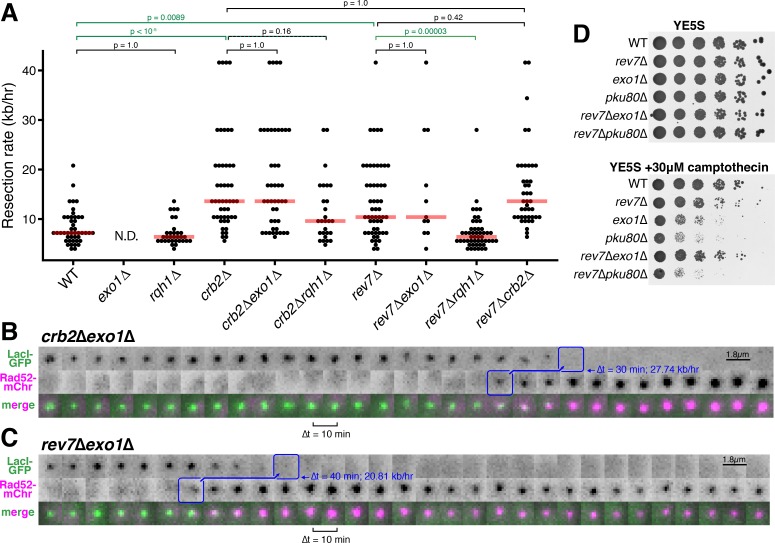
Rev7 and Crb2 act through the RecQ helicase, Rqh1, and not Exo1, to inhibit long-range resection.(A) Epistasis analyses of long-range resection rates from single-cell measurements. exo1∆ rates cannot be determined (N.D.) because resection through the LacO array does not complete within 5 hr of data acquisition. Red bars show median resection rates and p-values are from pairwise two-tailed t-tests, using a Bonferroni correction for multiple comparisons (significant comparisons shown in green). (B,C) Very rapid resection through the 10.3 kb LacO array is common in crb2∆exo1∆ (B) and rev7∆exo1∆ (C) cells, in contrast to exo1∆ single mutants that do not completely resect the LacO array within 5 hr (see Figure 1C). (D) Growth assay on rich media with and without camptothecin. Loss of Rev7 can rescue the severe growth defect of exo1∆ cells.